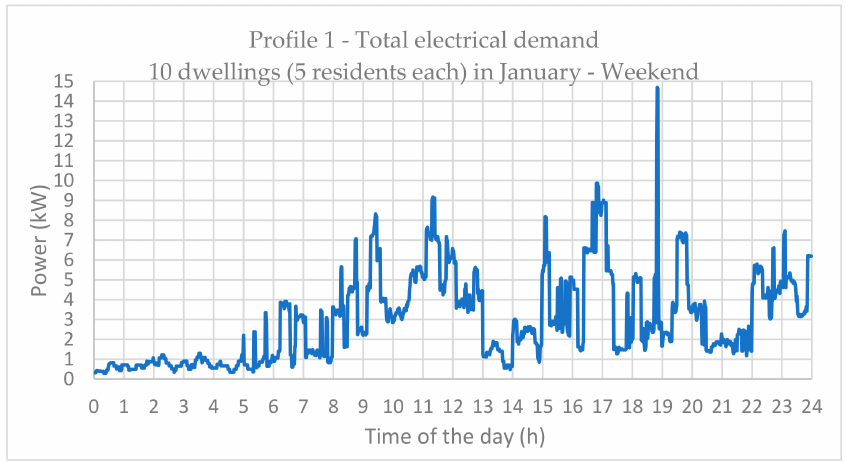
Figure 11. 24-h total electrical demand—Profile 1.